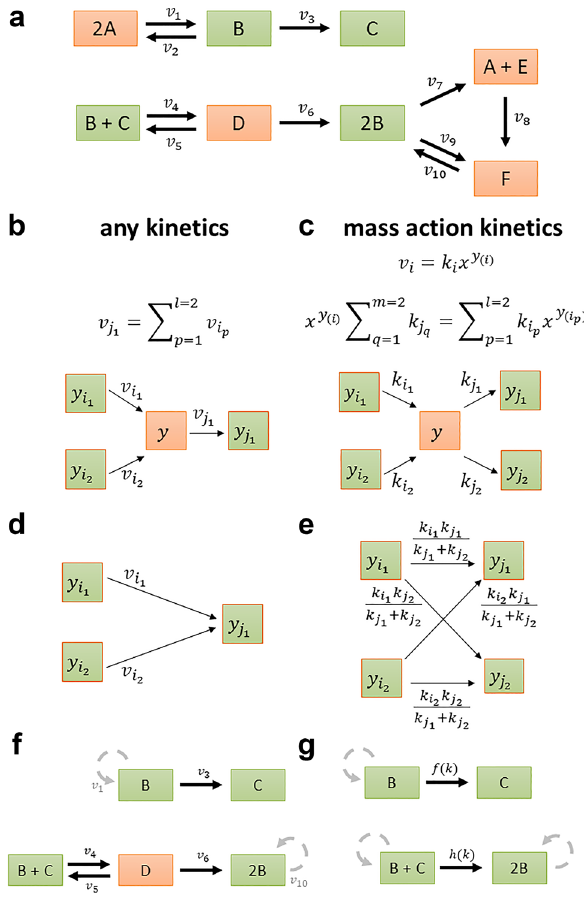
Figure 1. Balanced complexes for network reduction. ( a ) Toy example network borrowed from Shinar and Feinberg 33 , including six species, A–F, eight complexes, depicted as rectangles, and ten reactions, with rates v 1 – v 10 , each connecting two complexes. Balanced complexes are shown in orange, while non-balanced complexes are depicted in green. Balanced complexes 2A, A + E, and F have one outgoing reaction, while the balanced complex D has more than one outgoing reaction. Structural motif allowing removal of the balanced complex y ( b ) with single outgoing reaction, for an arbitrary kinetics and ( c ) with multiple outgoing reactions, for mass action kinetics. Removal of the complex amounts to substitution of variables, either with respect to reaction rates v or monomials of species concentrations x y , which can be represented by ( d ) network rewriting, for arbitrary kinetics and ( e ) additional scaling of reaction rate constants, with mass action kinetics. ( f ) Reduced network obtained by removing the balanced complexes 2A, A + E, and F; the loop reactions are shown in grey since they do not contribute to the stoichiometric matrix. ( g ) Reduced network obtained from the network in panel ( f ) after removal of the balanced complex D, assuming mass action. For simplicity, the rate constants are given as functions f ( k ) and h ( k )